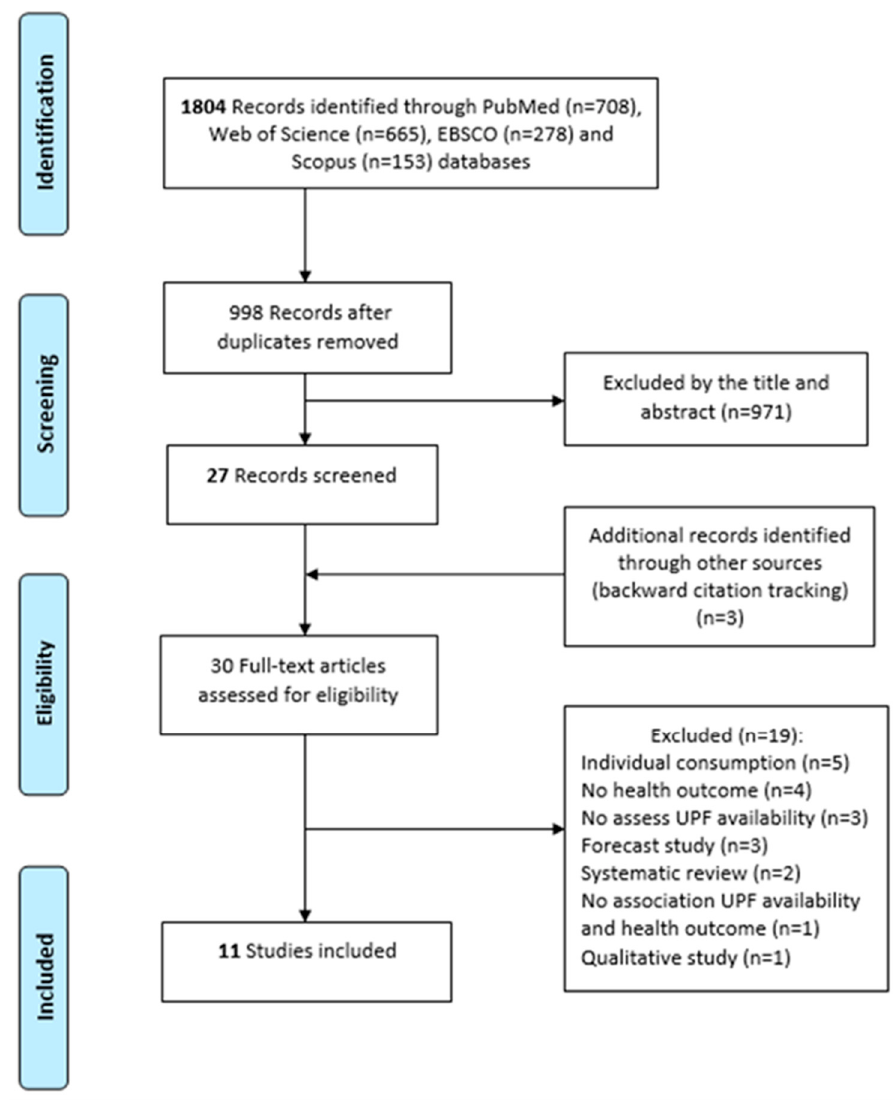
Figure 1. Flowchart of the study selection for the present systematic review. Table 1. Summary of the eleven studies included in the systematic review of UPF availability associated with health out- comes (February 2021).